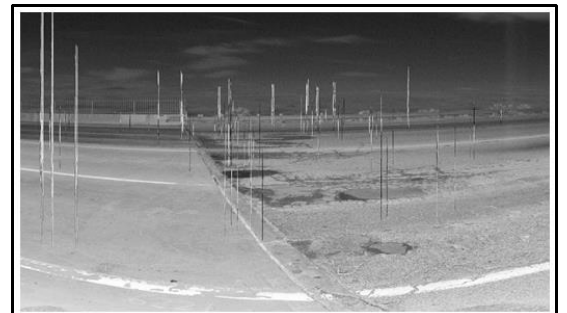
Figure 10. Passing traffic leaves noise in the LiDAR